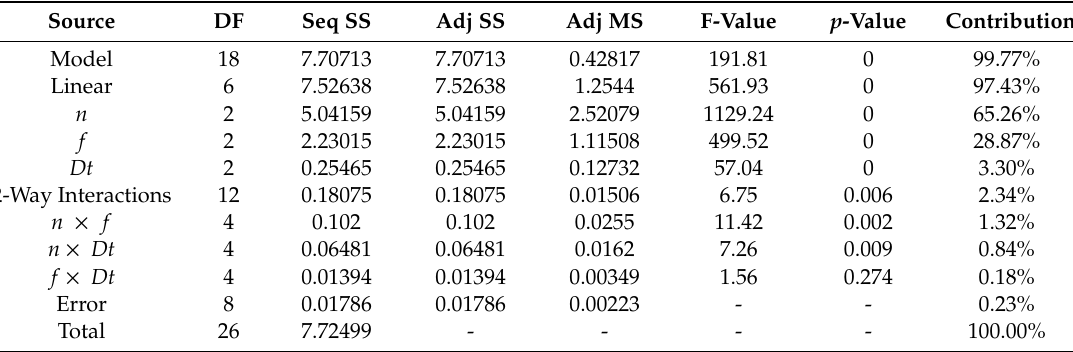
Table 3. ANOVA for surface